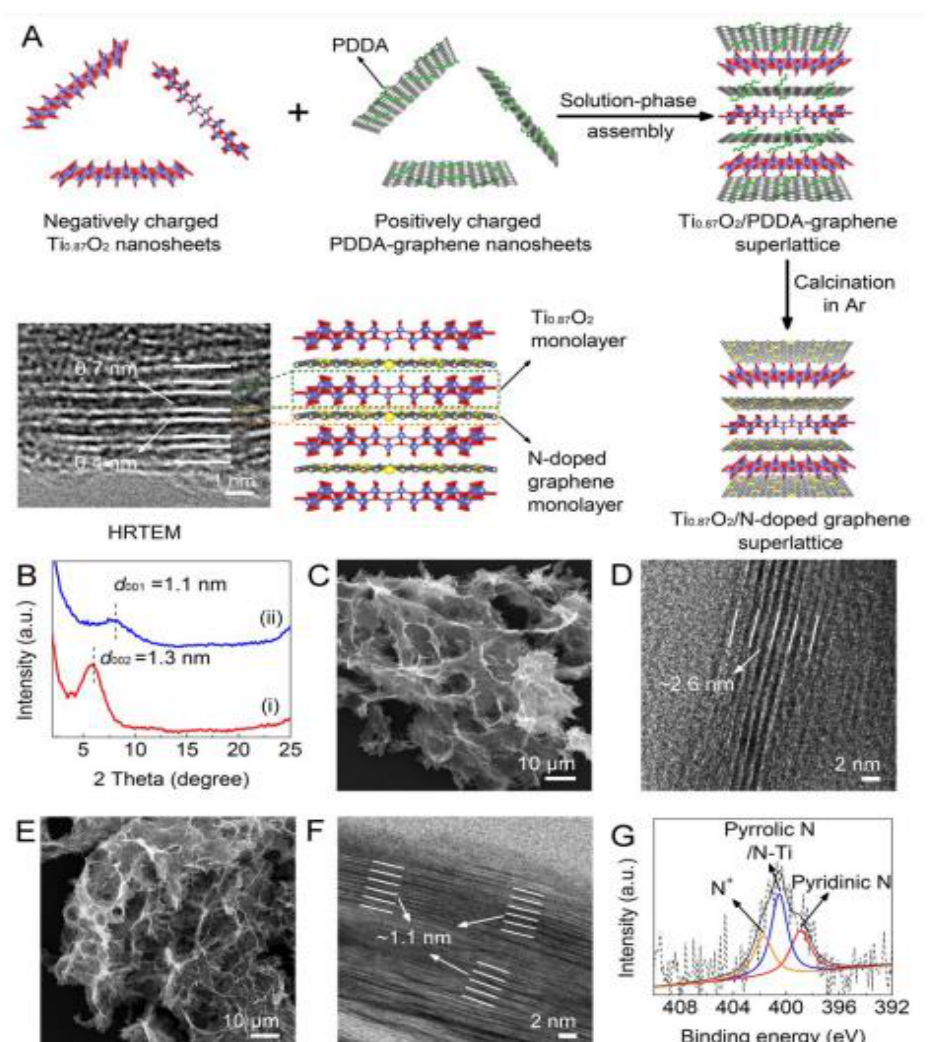
Figure 3. ( A ) Illustration of the synthesis approaches of the Ti0 0.87 O 2 /N-doped graphene superlattice. ( B ) XRD patterns of (i) Ti 0.87 O 2 /PDDA-graphene superlattices and (ii) Ti 0.87 O 2 /N-doped graphene superlattices. ( C ) SEM and ( D ) HRTEM images of Ti0 0.87 O 2 /PDDA-graphene superlattices. ( E ) SEM and ( F ) HRTEM images of Ti 0.87 O 2 /N-doped graphene superlattices. ( G ) High-resolution spectrum of N 1s in Ti 0.87 O 2 /N-doped graphene superlattices. Reprinted with permission from [42]. Copyright 2018 American Chemical Society .